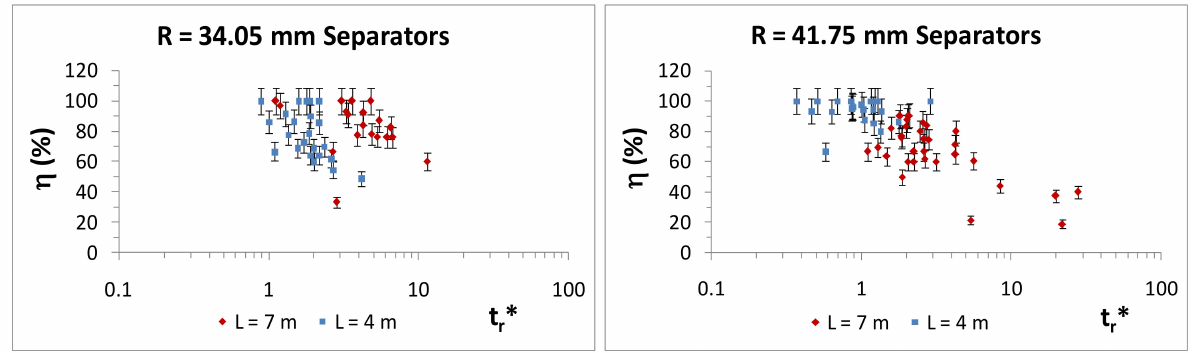
Figure 16. Relationship between t r * and η (%) for the separators tested with different helix radiuses R (34.05 mm and 41.75 mm) and tube lengths L (4 and 7